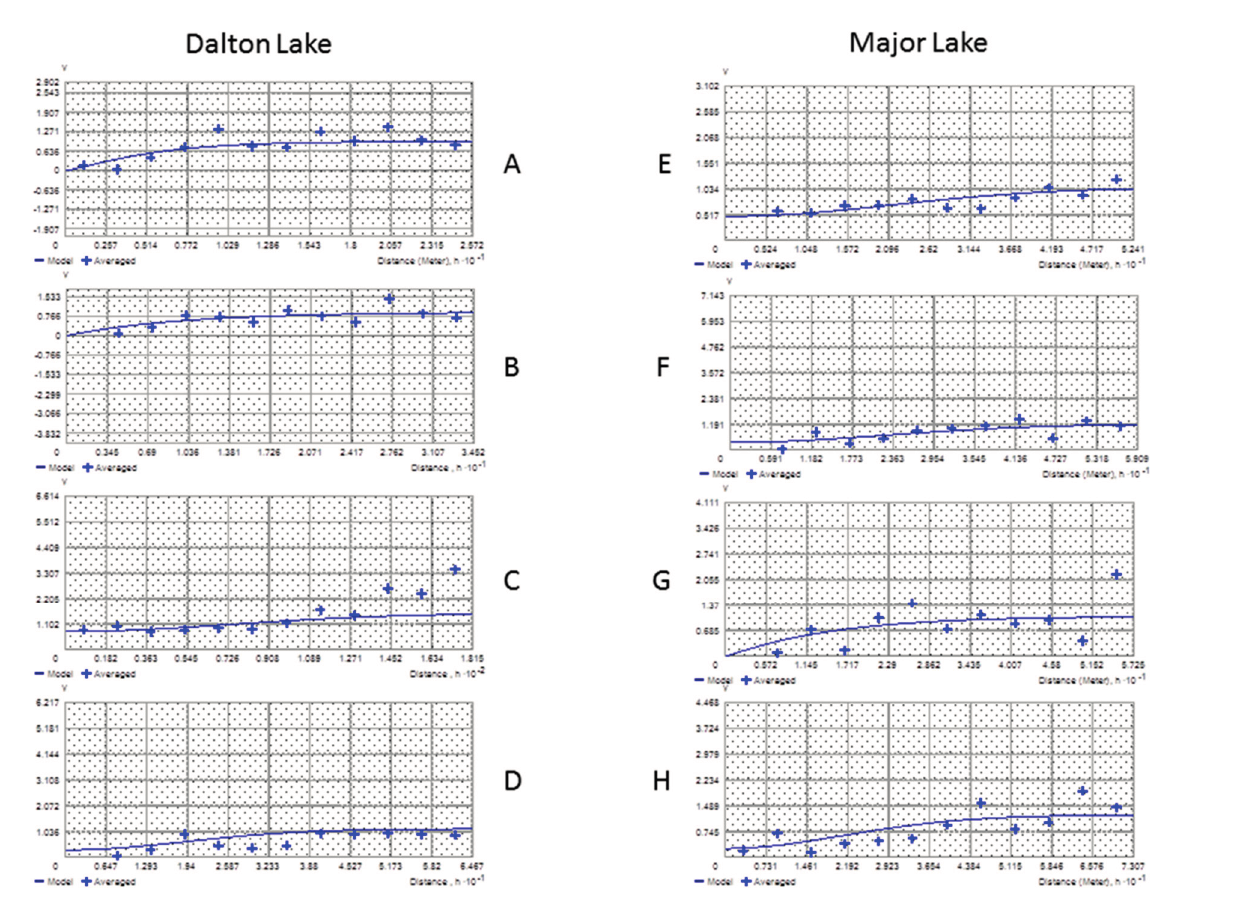
Figure 1. Semivariograms for total sample ( A and E ), 50% subsample ( B and F ), 33% subsample ( C and G ) and 25% subsample ( D and H ) of sediment data from Dalton Lake and Major Lake, South Dakota. Crosses are average measures of the empirical values of the semivariogram